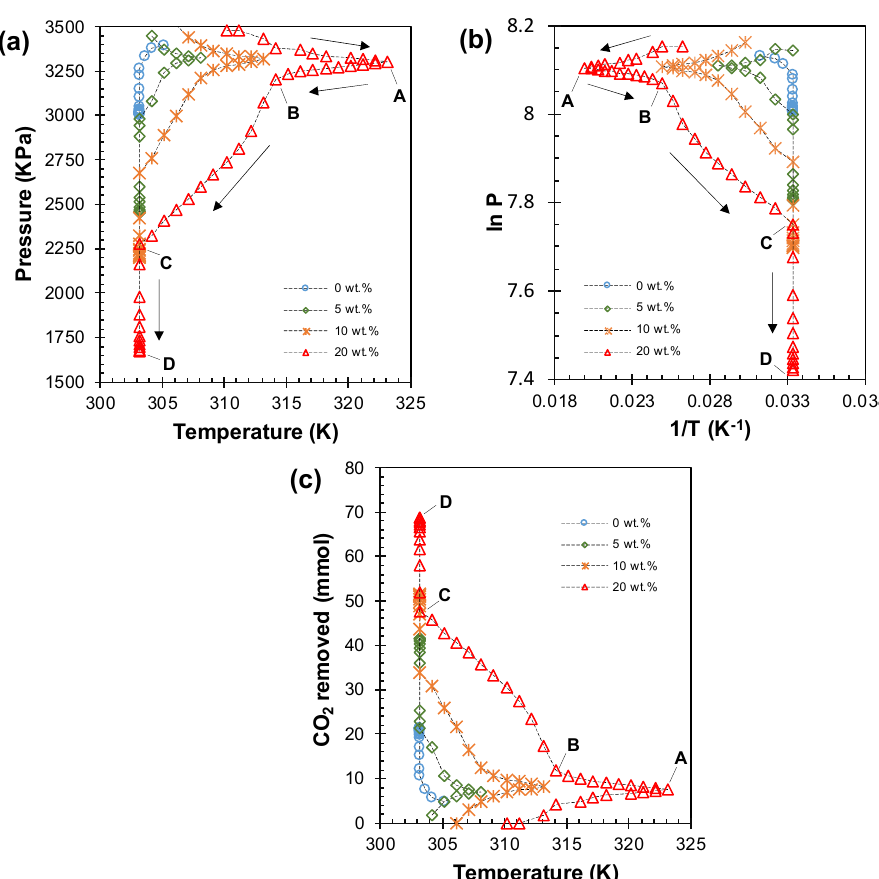
Figure 4. CO 2 capture using EDA—reaction exothermicity effects: ( a ) pressure–temperature diagram; ( b ) ln P vs. 1/T; ( c ) CO 2 removed vs. temperature.